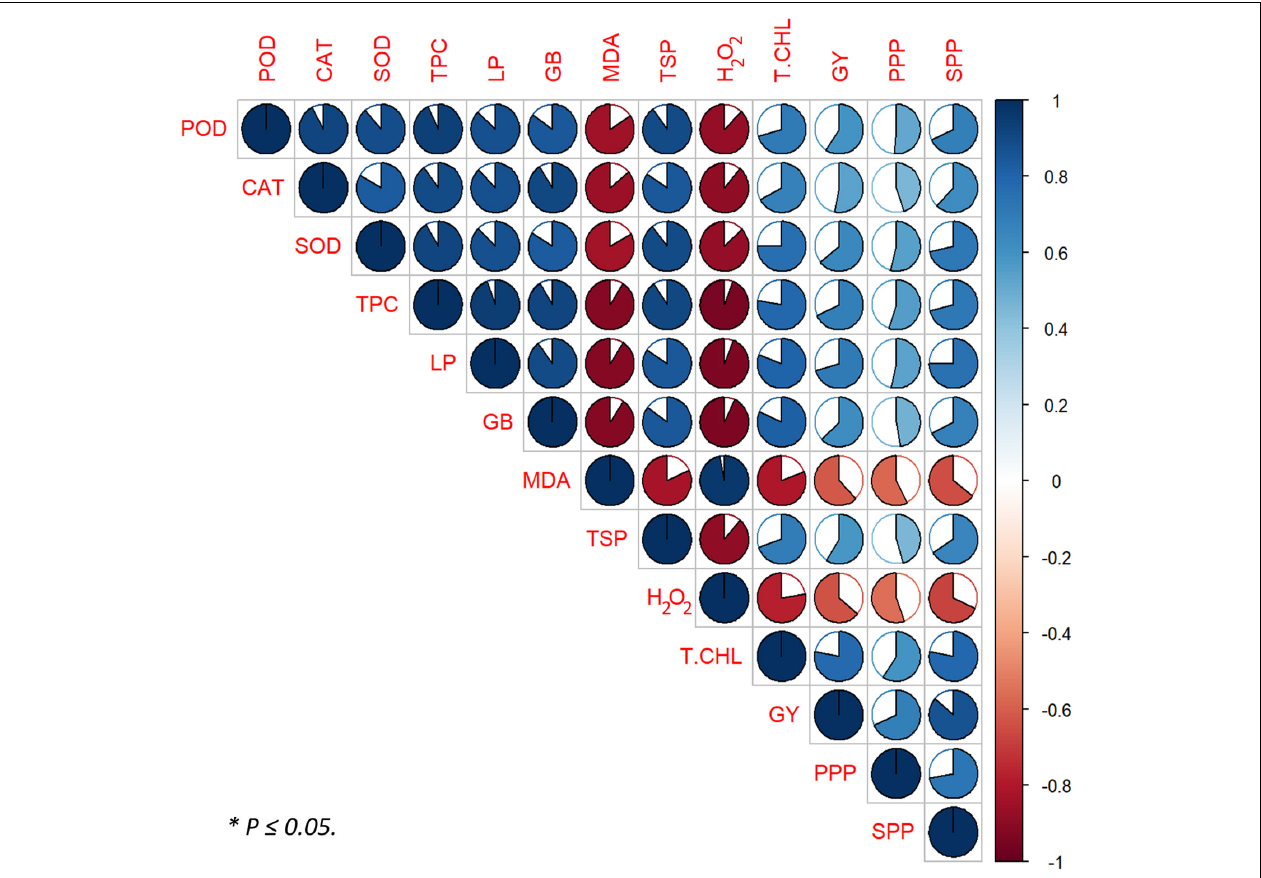
FIGURE 7 | Pearson’s correlation matrix between plant yield and biochemical attributes with foliar-applied nano-ZnO under sowing time generated heat stress. Correlations are displayed in blue (positive) and red (negative); color intensity and circle size are proportional to the correlation coefficient. POD, peroxidase; CAT, catalase; SOD, superoxide dismutase; TPC, total phenolic content; LP, leaf proline; GB, glycine betaine; MDA, malondialdehyde; TSP, total soluble protein; H 2 O 2 , hydrogen peroxide; T.CHL, total chlorophyll; GY, grain yield; PPP, pods per plant; SPP, seeds per